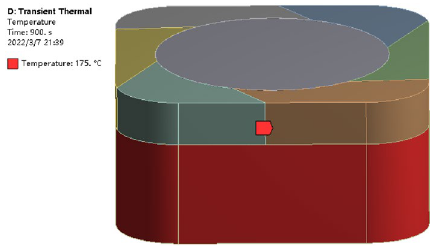
Figure 8. Temperature setting.